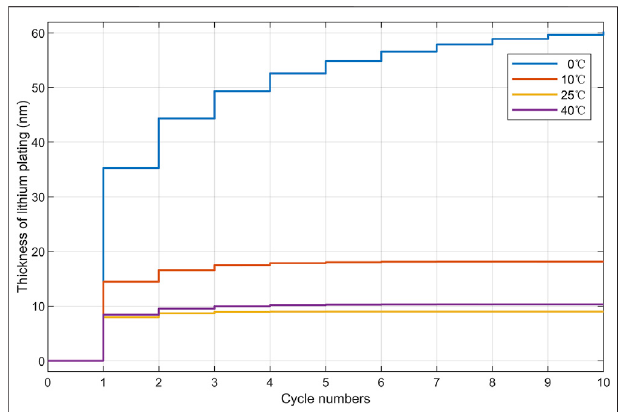
FIGURE 6 | In fl uence of temperature on lithium plating thickness charged under